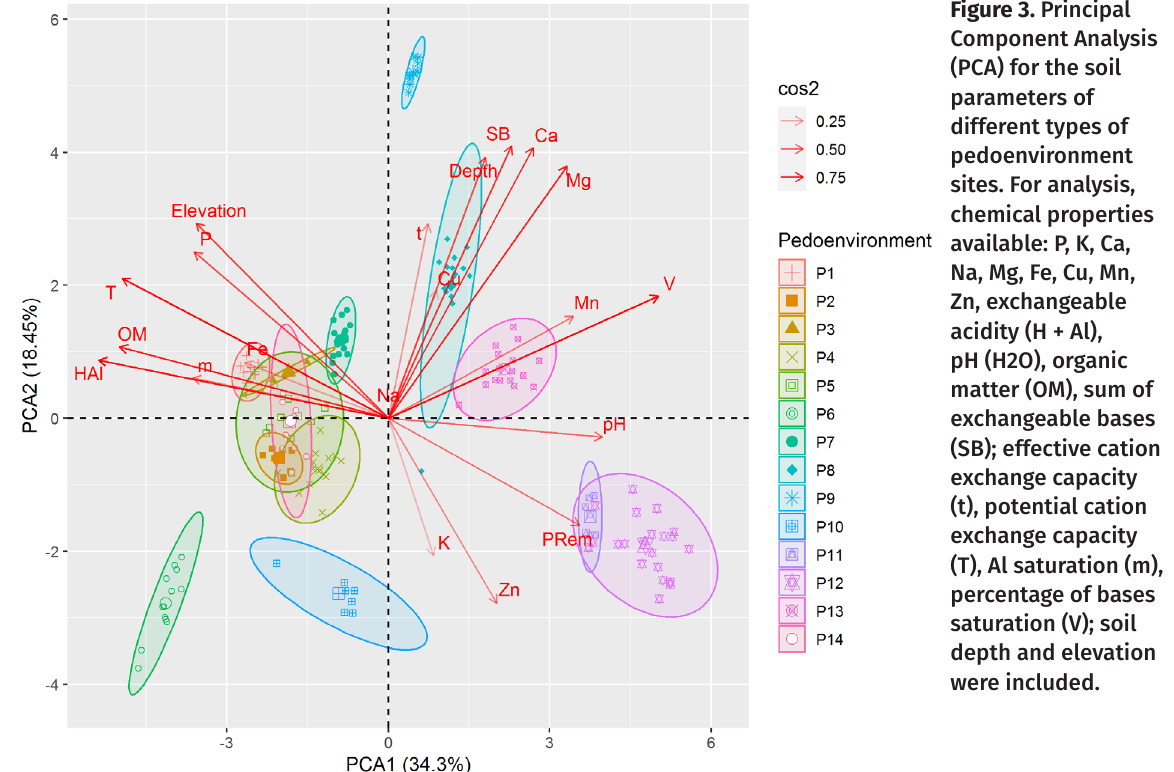
Figure 3. Principal Component Analysis (PCA) for the soil parameters of different types of pedoenvironment sites. For analysis, chemical